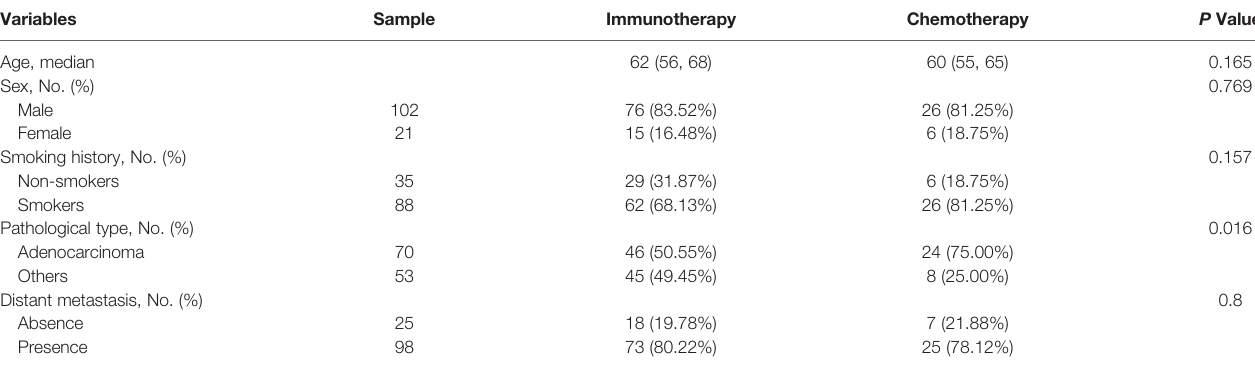
TABLE 2 | Baseline clinical characteristics comparison of patients between immunotherapy training set and chemotherapy cohorts. Variables Sample